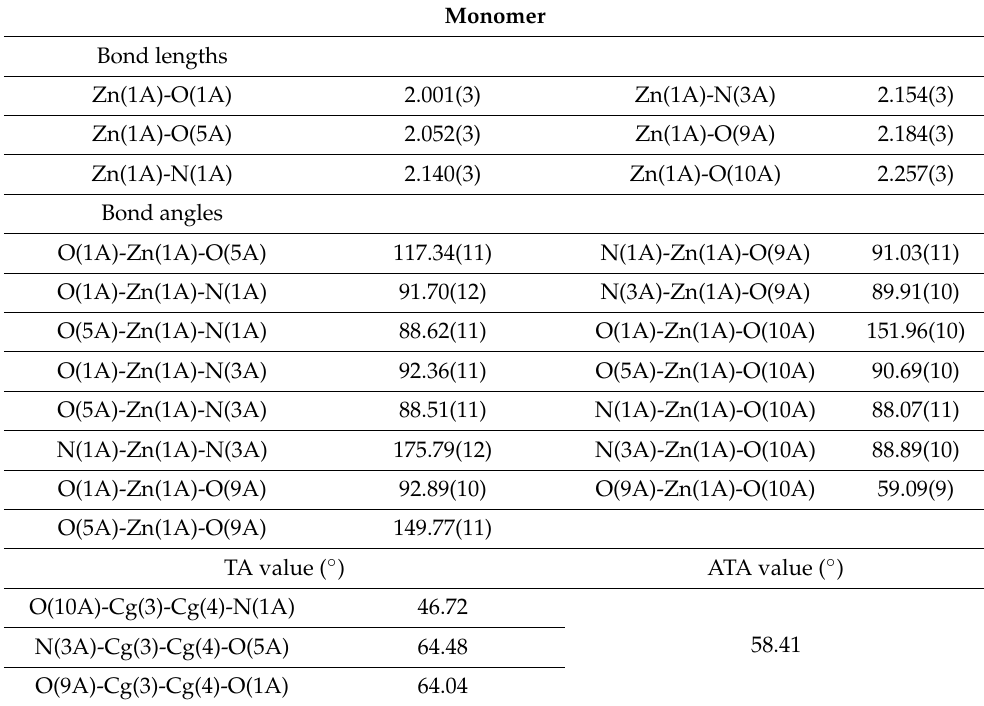
Figure 2. ( a ) Molecular structure of the dimeric and monomeric units in complex 2 . ( b ) Representation of the dimeric and monomeric Zn (II) cores. Inset of the intra- and intermolecular interactions between HPip and MeOH with μ 1 - η 1 -Pip ligand. Table 2. Bond lengths (Å), bond angles (°) and intramolecular interactions in 2 .